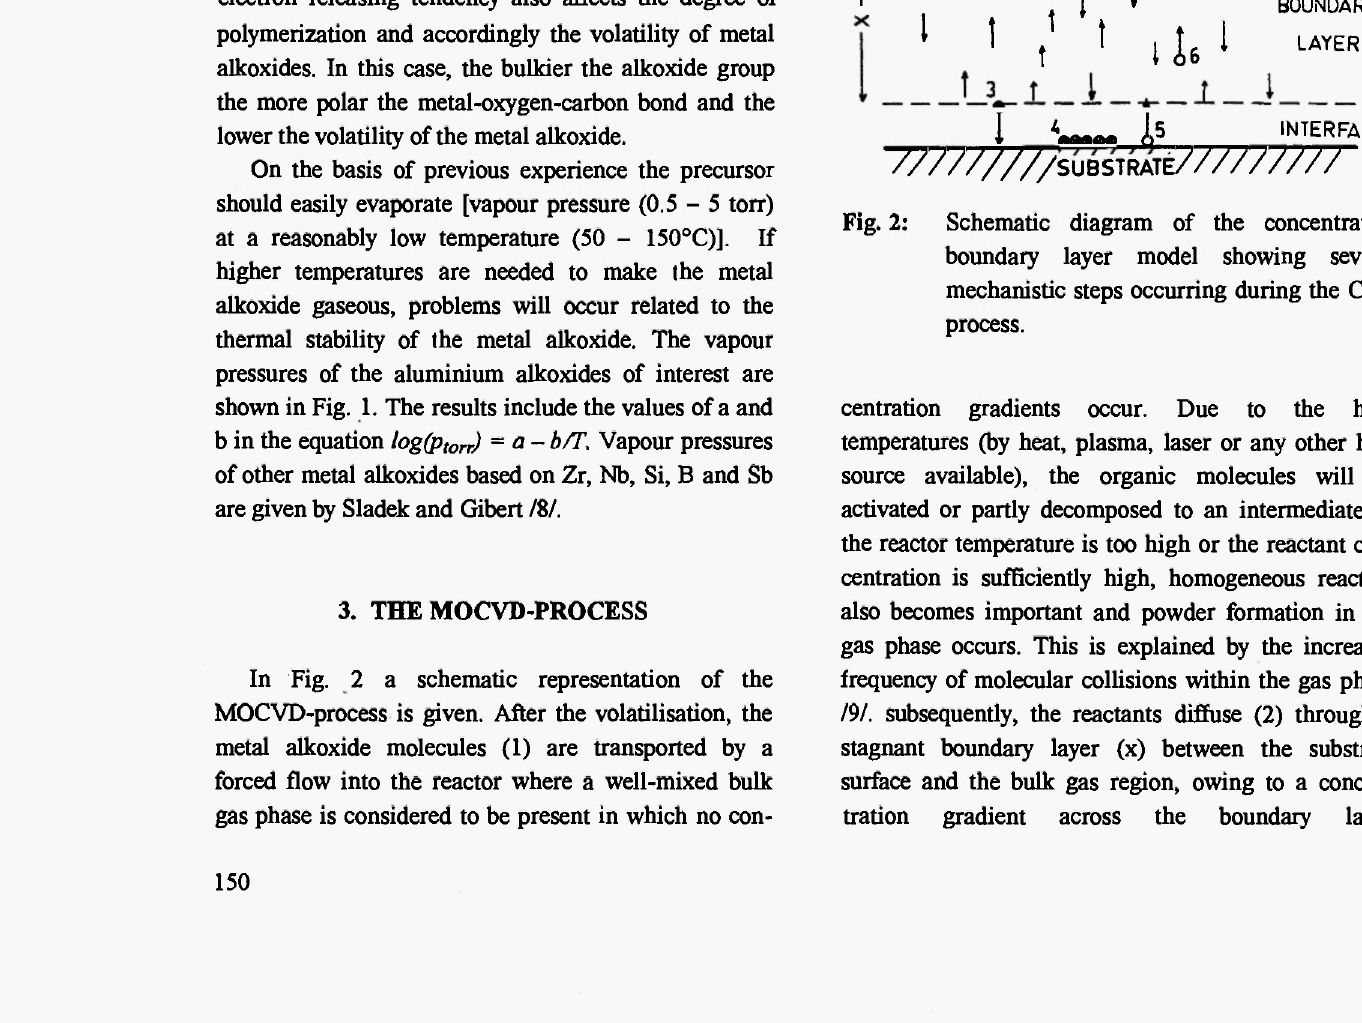
BULK GAS BOUNDARY